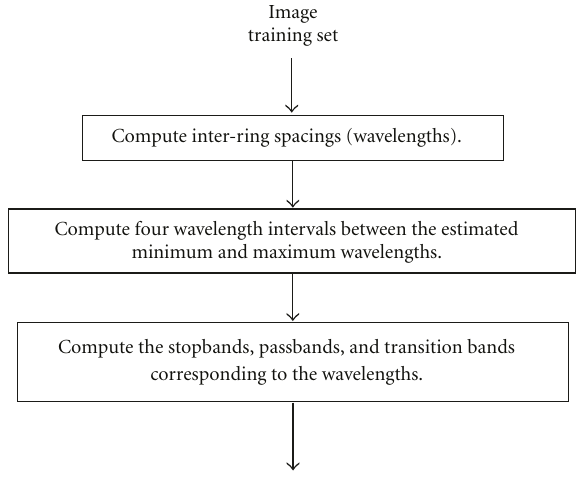
Figure 4: Filterbank specification from image training set. For uniformwavelength spacing design, the four passbandsare set equal to 1/4th of the spacing between the minimumfrequency (maximum wavelength) and the maximum frequency (minimum wavelength). For variable frequency spacing, we look at the distribution of the interring spacings in the training set. The basic idea is to search for three jumps (edges) in the interring spacing histogram. Starting from the minimum frequency we select the first interval to the first jump (edge), and so forth, until the maximum frequency.